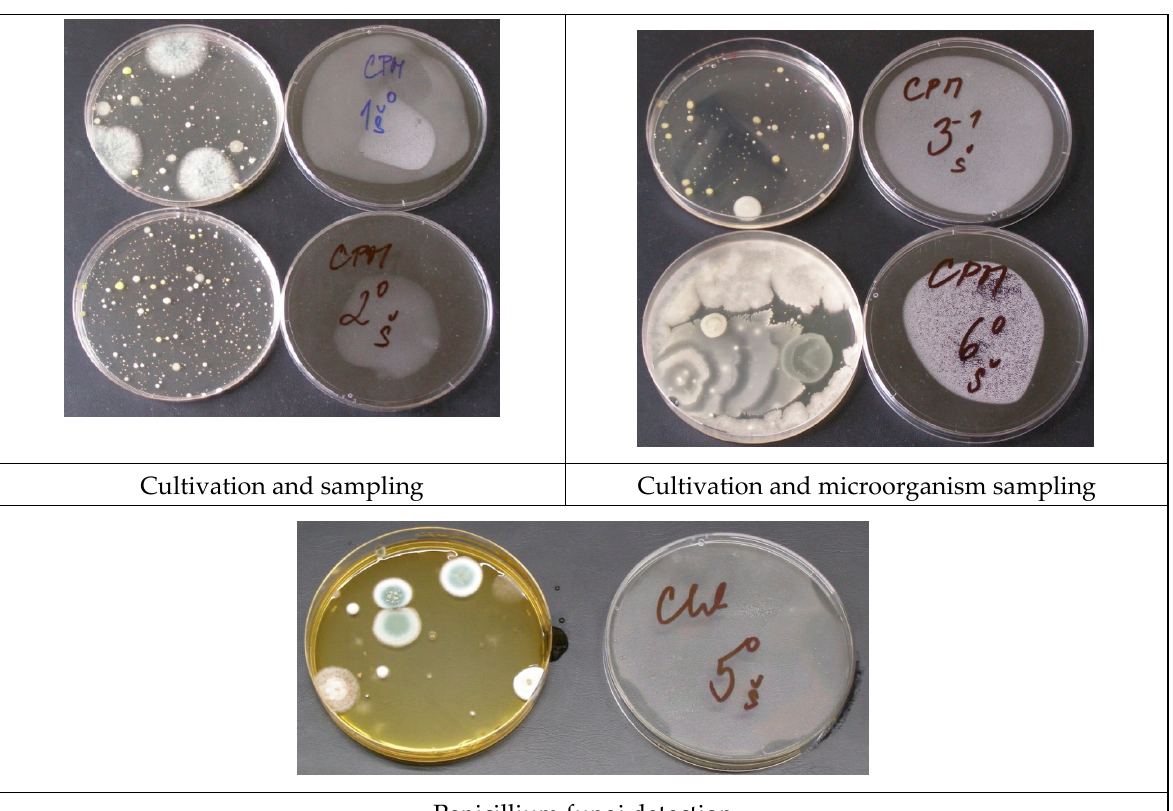
Figure 11. Photographs from the microbiological testing.